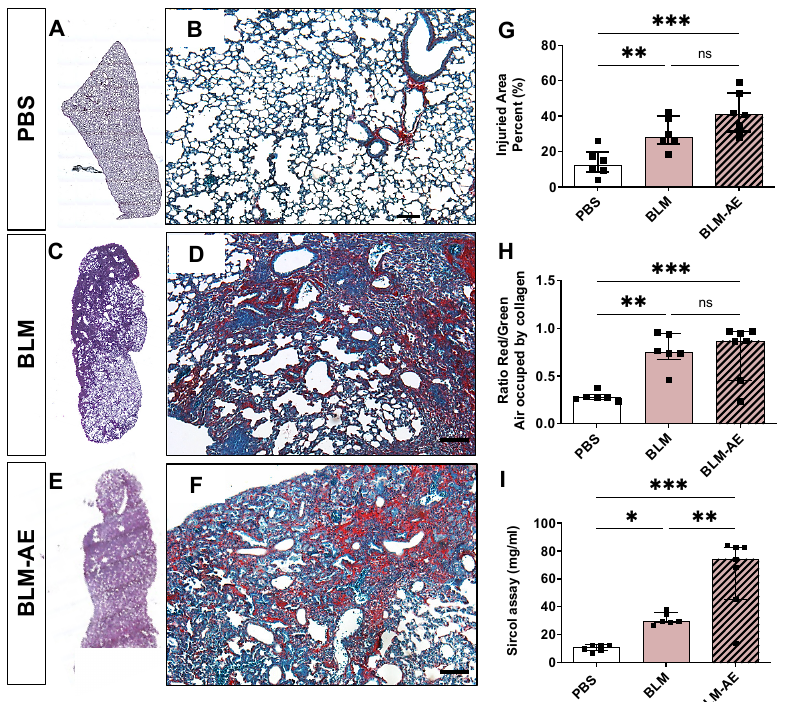
Figure 2. Histological study and analysis of collagen deposits. ( A , C , E ) Representative mapping of hematoxylin and eosin-stained from the PBS ( A ), BLM ( C ) and BLM-AE ( E ) groups to evaluate global lung architecture. ( B , D , F ) Representative Sirius red and fast green lung sections from the PBS ( B ), BLM ( D ) and BLM-AE ( F ) groups (scale bar corresponding to 100 μ m) to evaluate collagen deposits and lung remodeling. ( G ) Lung injured area was estimated by quantification of sections density after H&E staining using HistoLab® image analysis software and expressed as the percentage of the total lung section. Injury quantification was normalized to the mean value of control group and presented as a percentage. ( H ) Light microscopy quantification of Sirius red staining reported to fast green staining quantification. ( I ) Quantification of soluble collagen in the right lung middle lobe by the Sircol method. ( G – I ) Data were presented as a box plot representing the median ± interquartile range. Raw data were submitted to one-way ANOVA test followed by Newman–Keuls to compare each group (control PBS group (white bar), BLM group (pink bar) and BLM-AE group (pink hatched black bar)), ns: not significant, * p < 0.05, ** p < 0.01, *** p < 0.001, respectively.